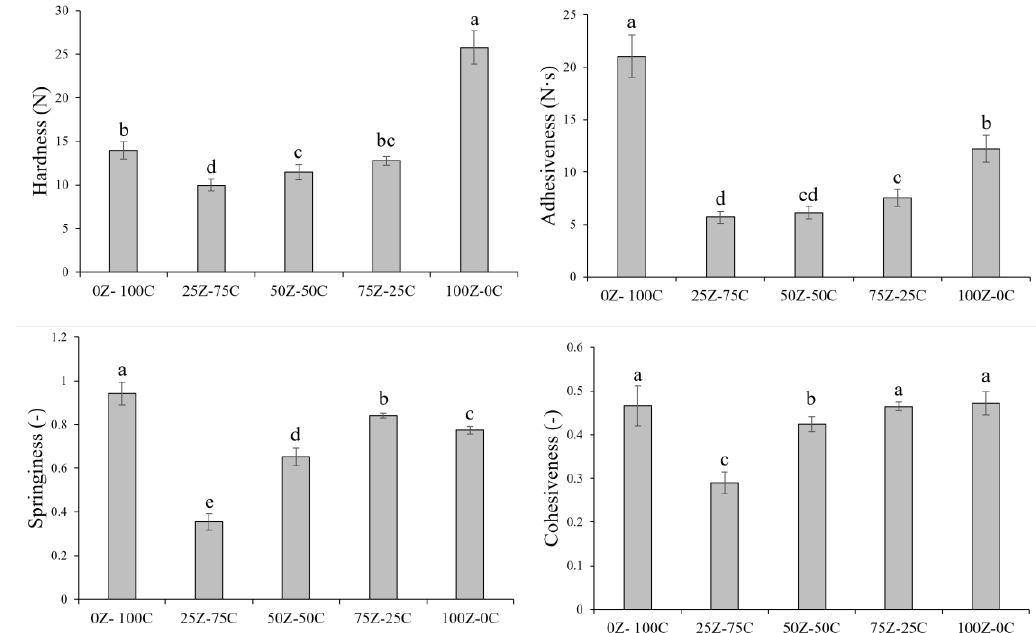
Figure 9. Texture profile analysis parameters, hardness, adhesiveness, springiness and cohesiveness of plant-based cheese alternative samples. Different letters (a–e) indicate significant differences between samples ( p <